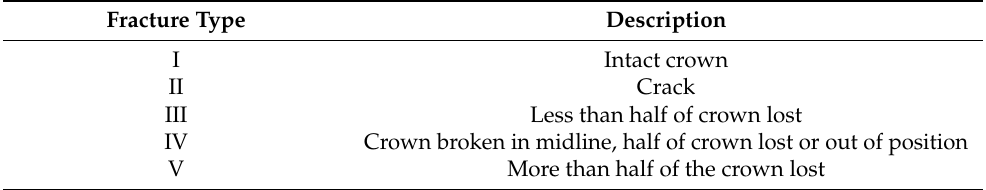
Table 2. Burke’s classification.